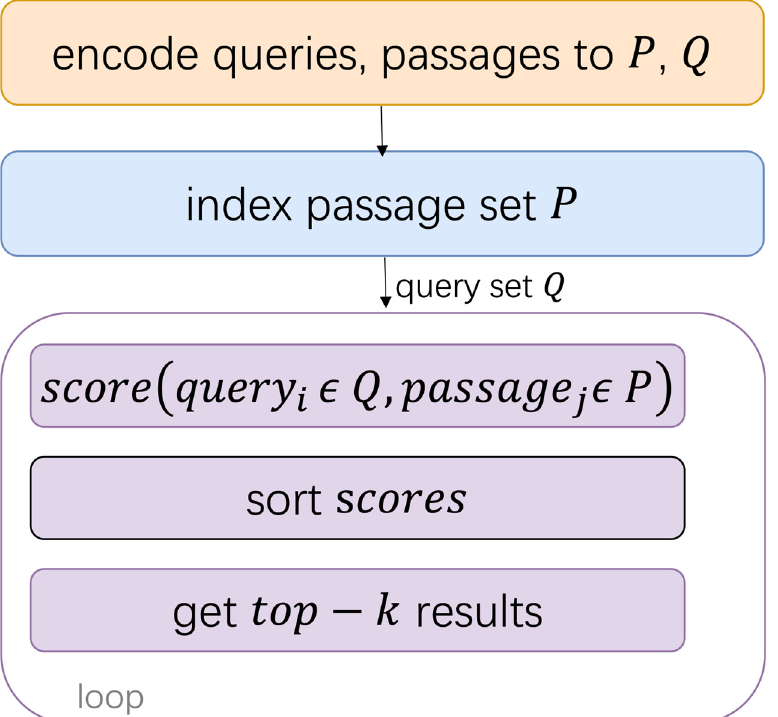
Figure 1. DPR Dense Retrieval